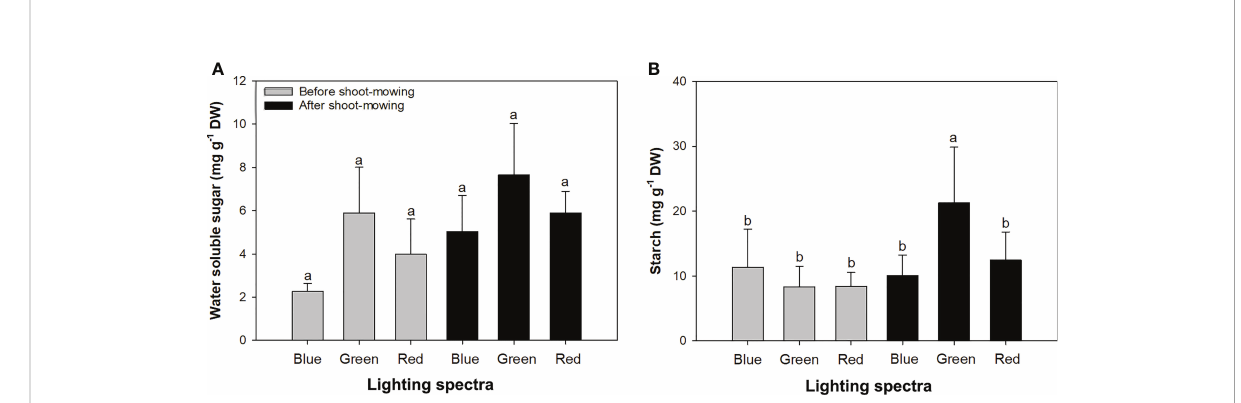
FIGURE 3 Contents of water-soluble sugar (A) and starch (B) in mowed alfalfa shoots exposed to varied spectra of blue, green, and red lights. Different lowercase letters indicate signi fi cant differences at 0.05